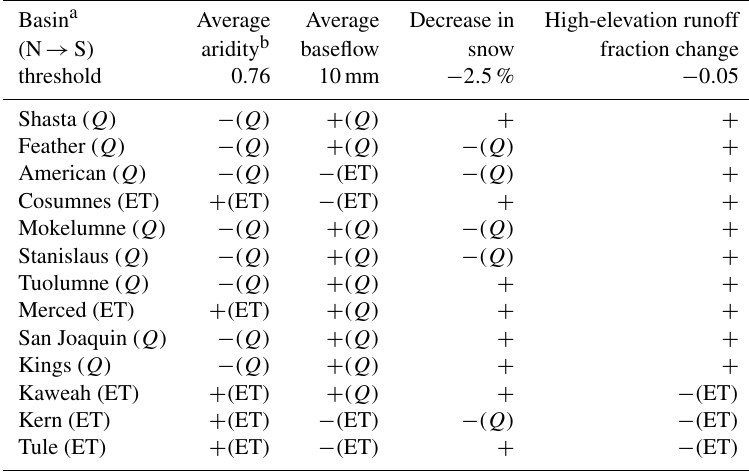
Table 2. Summary of basin response mechanisms influencing water partitioning relative to the stated threshold. Basin